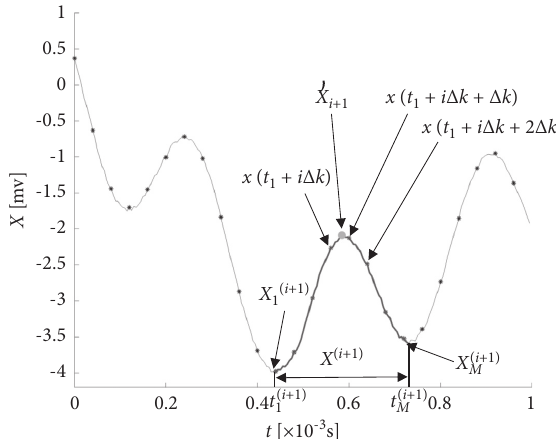
Figure 25: A pulse signal cycle X ( i + 1 ) .